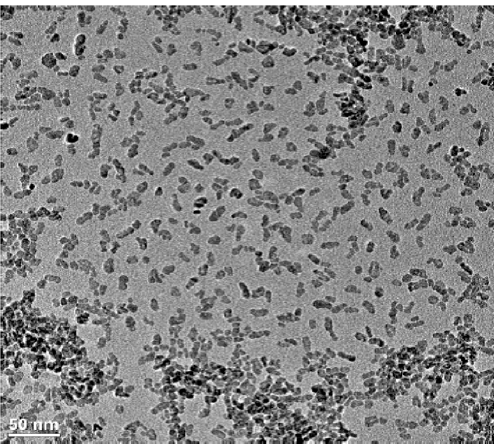
Figure 1. TEM image of the as-prepared α -Fe 2 O 3 nanoparticle sample.